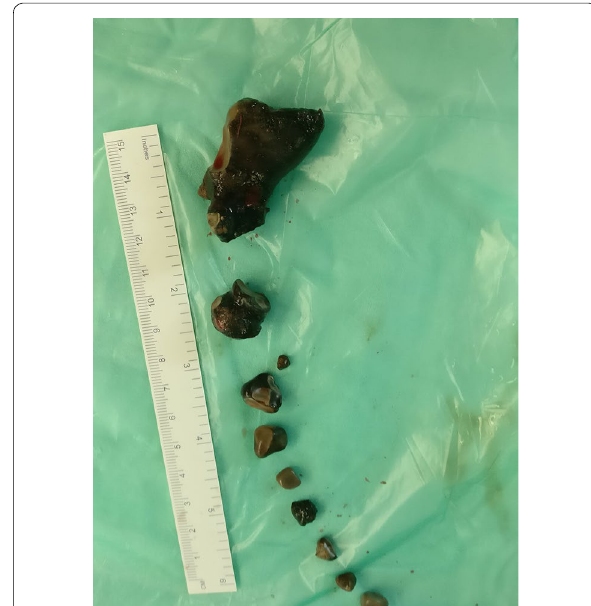
Fig. 6 All stones retrieved arranged in order